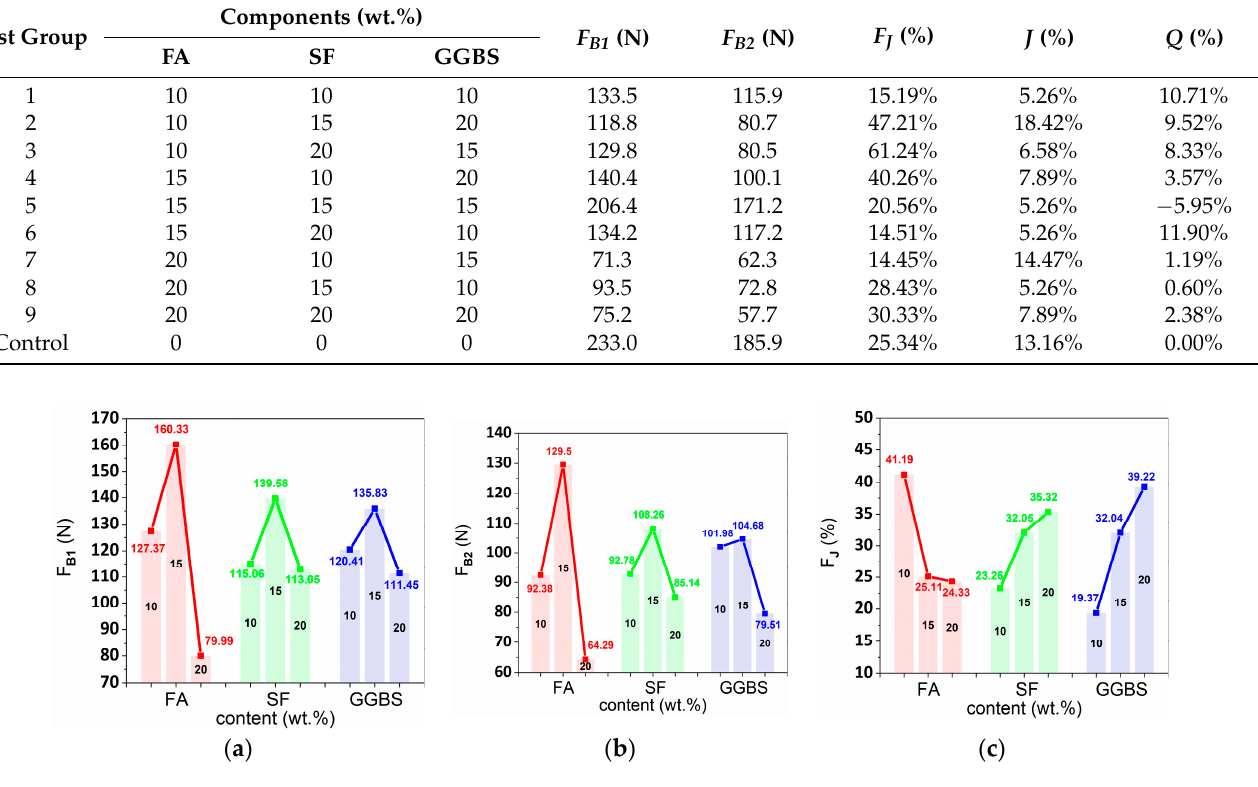
Table 5. Summary of printable performance test and calculation results. Test Group